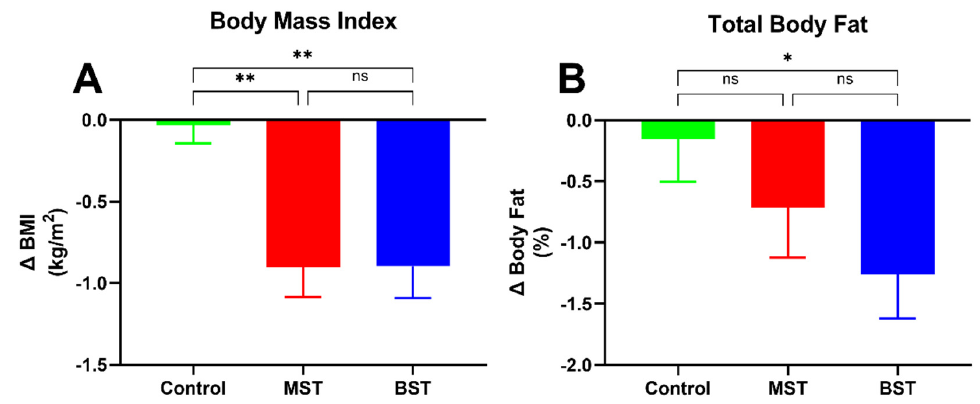
Figure 5. ( A ) Change ( ∆ ) in BMI, ( B ) change in total body fat (†) percentage Data are presented as mean ( ± SEM). (*) p < 0.05, (**) p < Figure 5. (A) Change ( Δ ) in BMI , (B) change in total body fat (†) percentage Data are presented as mean (± SEM). (*) p < 0.05, (**) p < 0.01.